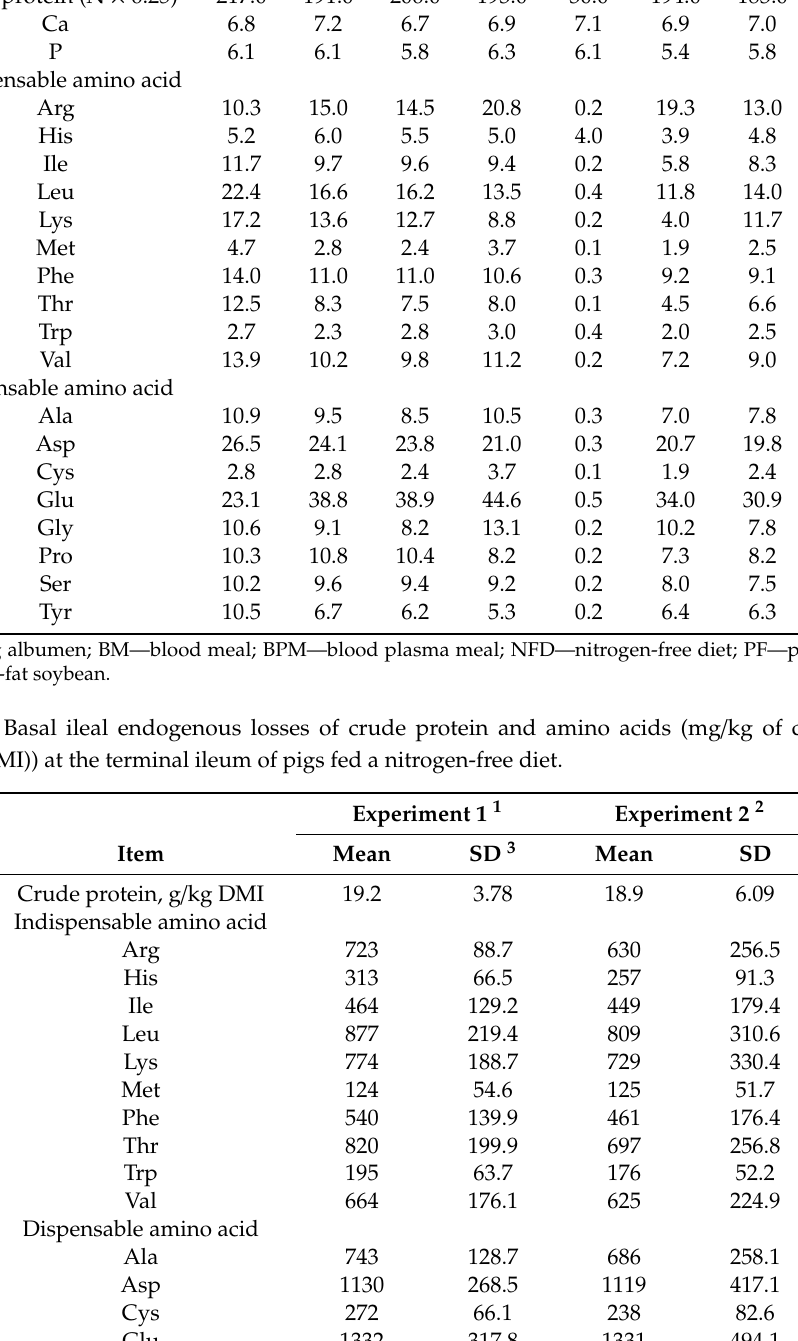
Crude protein (N × 6.25)